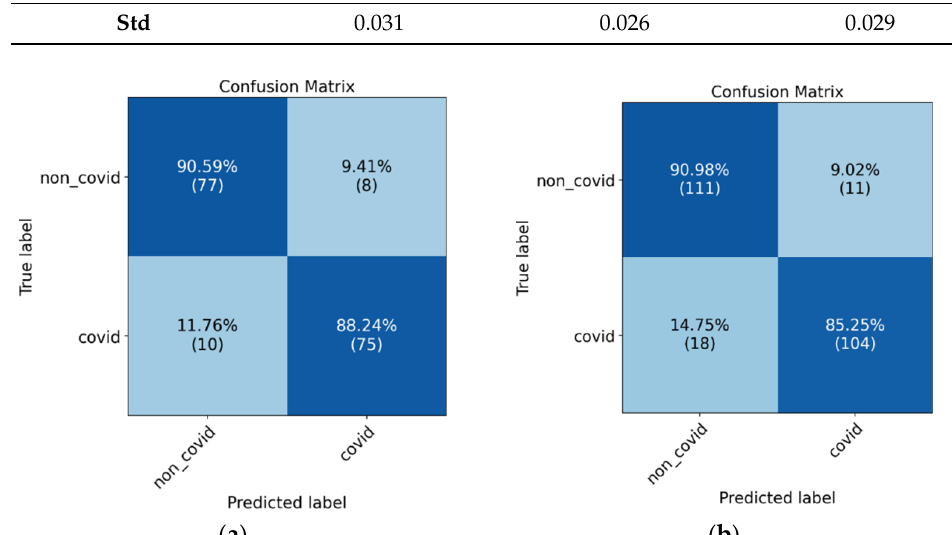
Figure 7. Confusion matrix results for model evaluation on the test datasets, ( a ) test dataset 1, and ( b ) test dataset 2.